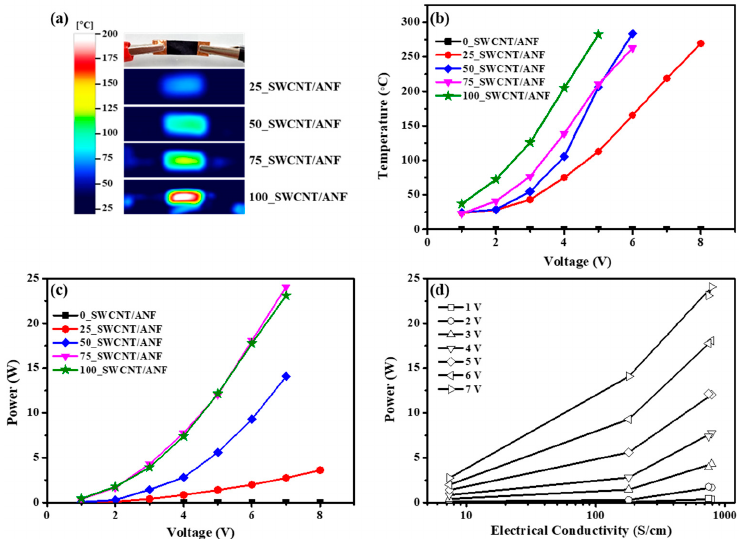
Figure 6. Joule heating effect according to SWCNT content: ( a ) image (thermal imaging camera) of Joule heating system and the resulting temperatures when 4 V was applied, ( b ) temperatures depending on the voltages, ( c ) electric power depending on the input voltages, ( d ) electric power depending on electrical conductivity.